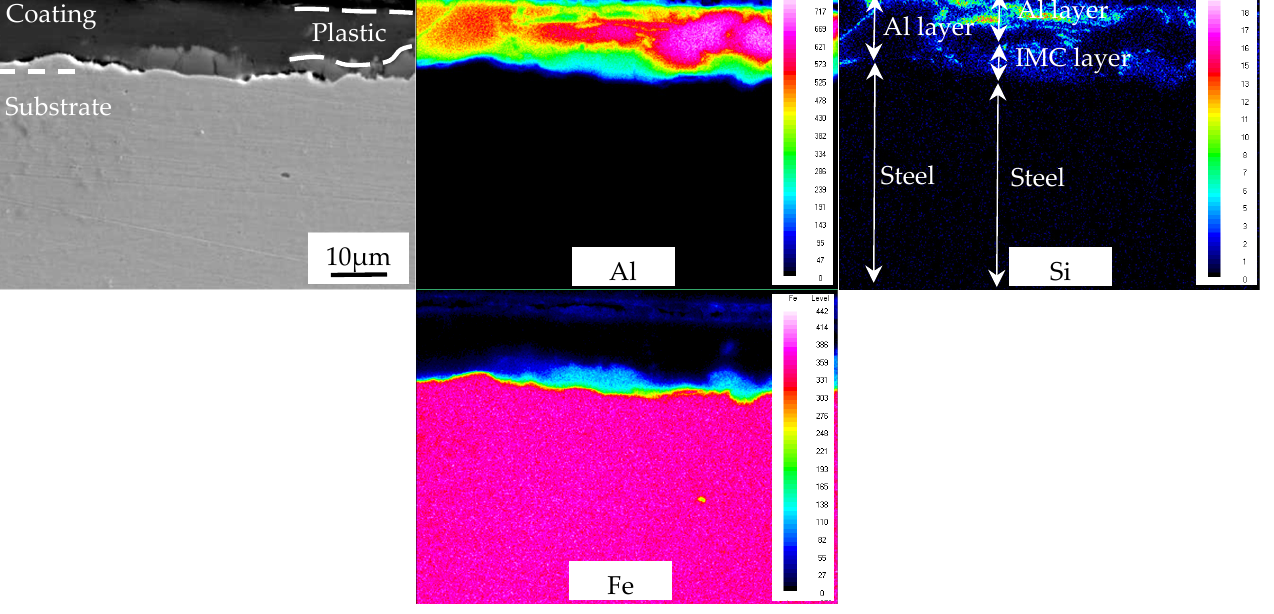
Figure 6. EDS map scan of interface between the AS60/60 coating and the steel substrate at 50% reduction ratio.